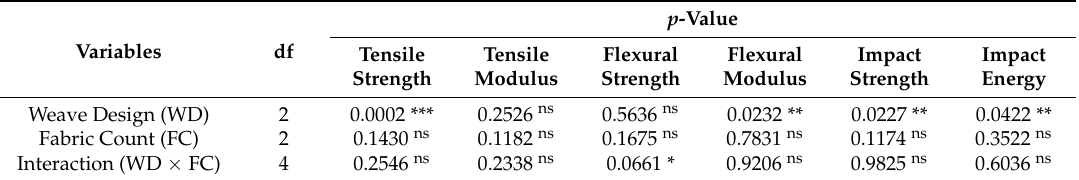
Table 5. Summary of ANOVA on the mechanical properties of woven kenaf/carbon fibre hybrid